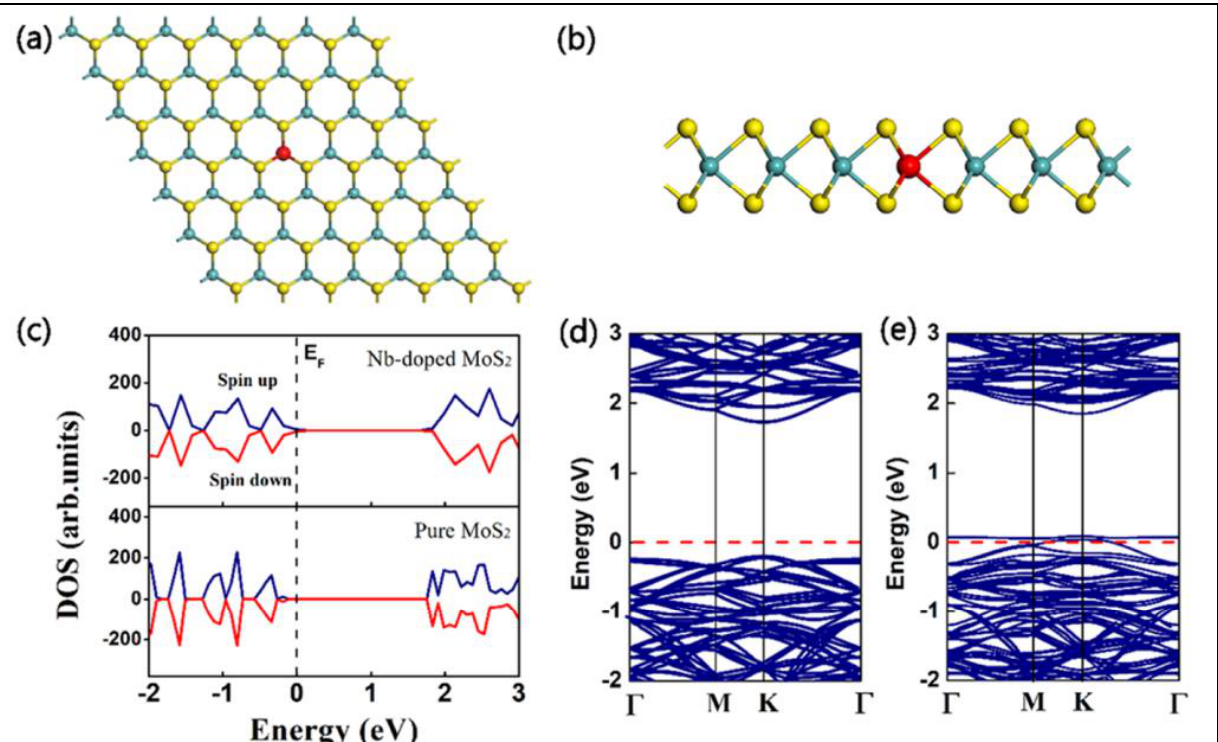
Figure 12. Geometries of 7 × 7 supercell of Nb-doped MoS 2 in its ( a ) top and ( b ) side view. ( c ) Com- parison of the total density of states plot of Nb-doped (upper panel) and pristine MoS 2 (lower panel). Band structure plots of ( d ) pristine MoS 2 ( e ) Nb-MoS 2 , Reprinted from Ref. [189].